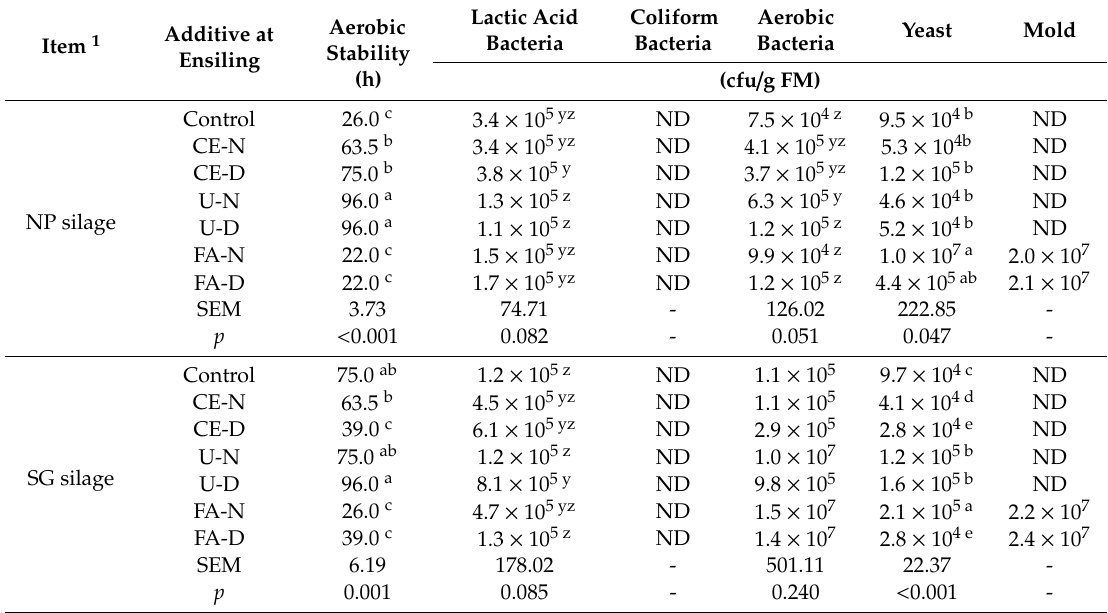
Table 5. Aerobic stability and microbial populationof silages after 30 d of fermentation.